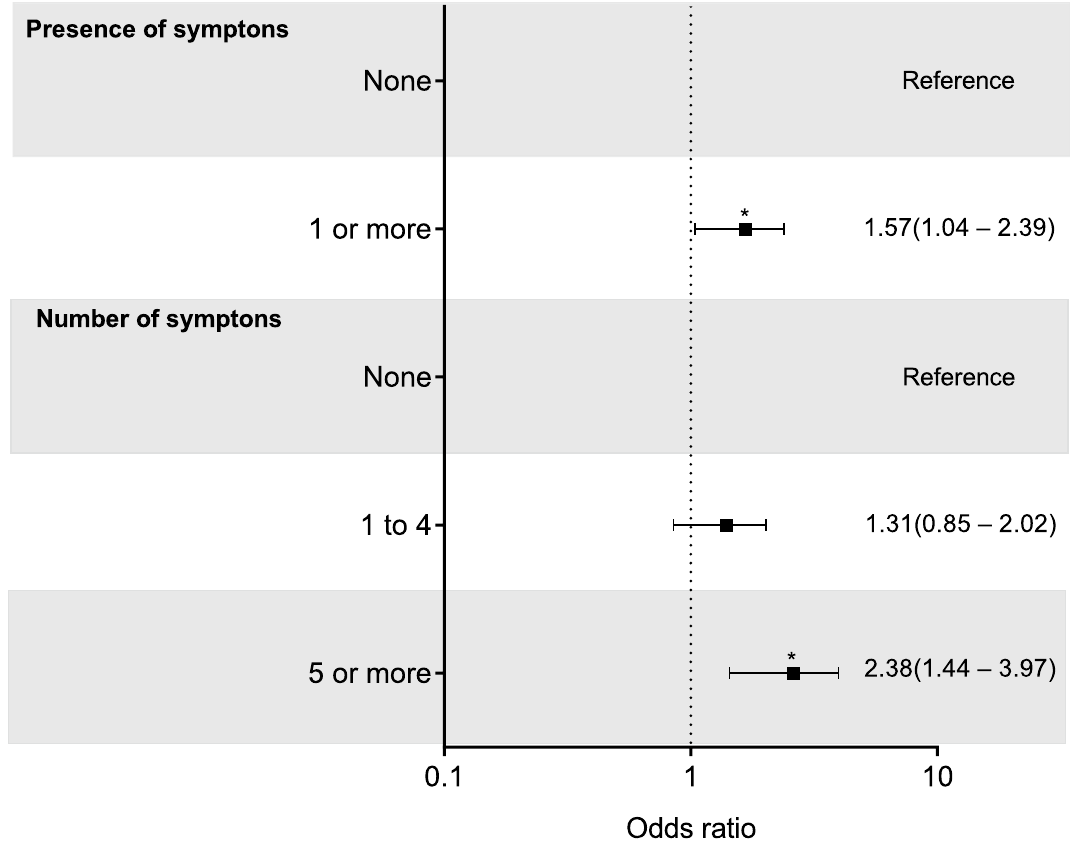
Figure 1. Multivariate-adjusted logistic regression analysis (odds ratio [(95% CI]) of the association between presence and number of persistent symptoms related to COVID-19 (i.e., none, 1–4 and ≥ 5 symptoms) with physical inactivity (< 150 min/week of moderate-to-vigorous activity). *indicates P <